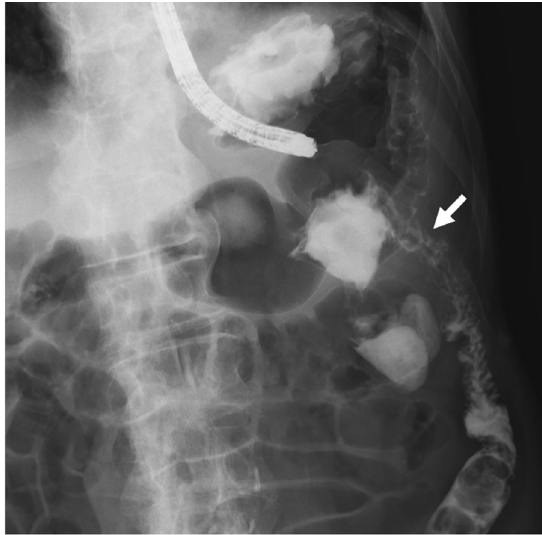
Fig. 3 Upper gastrointestinal series confirmed a fistulous path to the colon from the stomach. The white arrow indicates gastrocolic fistula